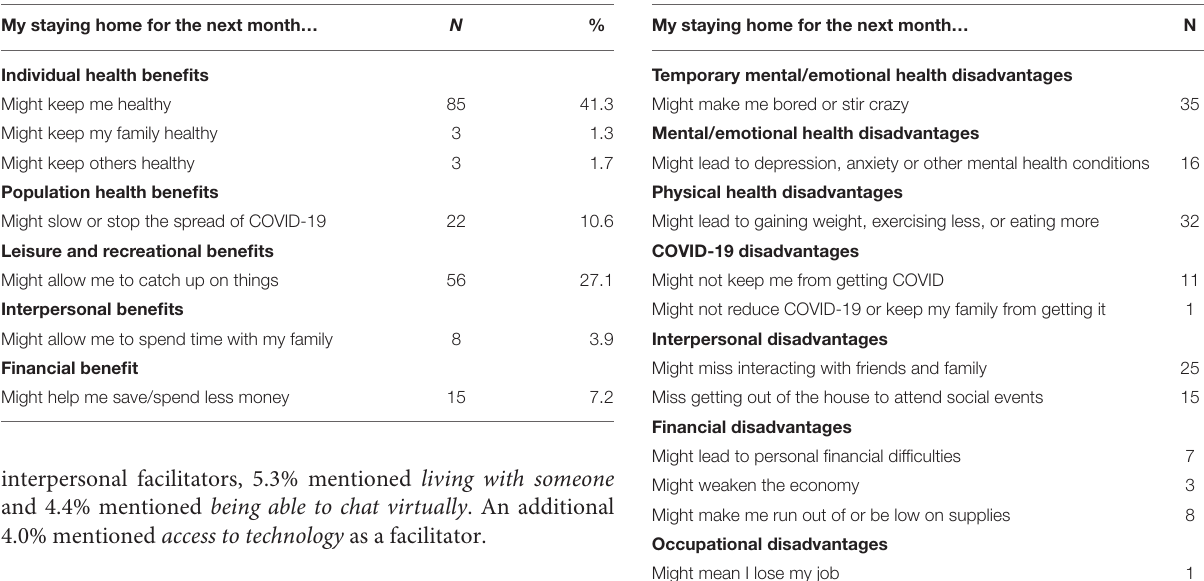
TABLE 3 | Frequency of perceived advantages of staying home. TABLE 4 | Frequency of perceived disadvantages of staying